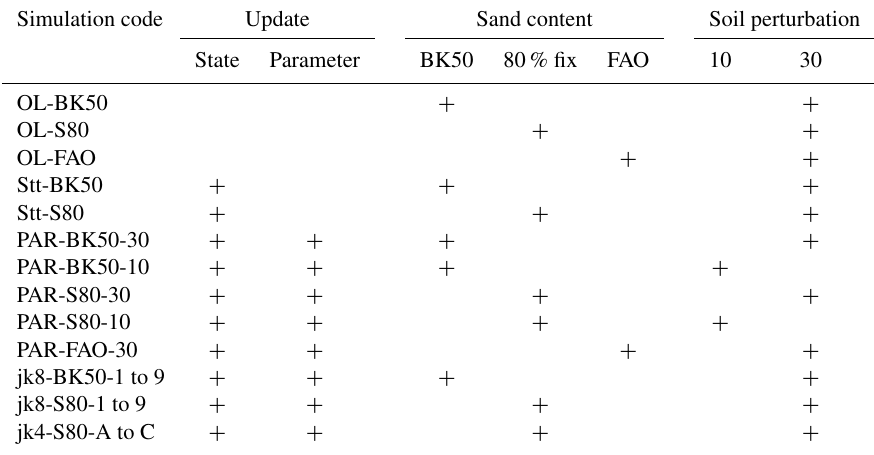
Table 2. Overview of simulation scenarios: open loop (OL- ∗ ) with variation in the soil maps BK50, FAO and S80, data assimilation run with state update (Stt) or joint state and parameter update (PAR) with variation in the soil map perturbation ( − 10 and − 30), and